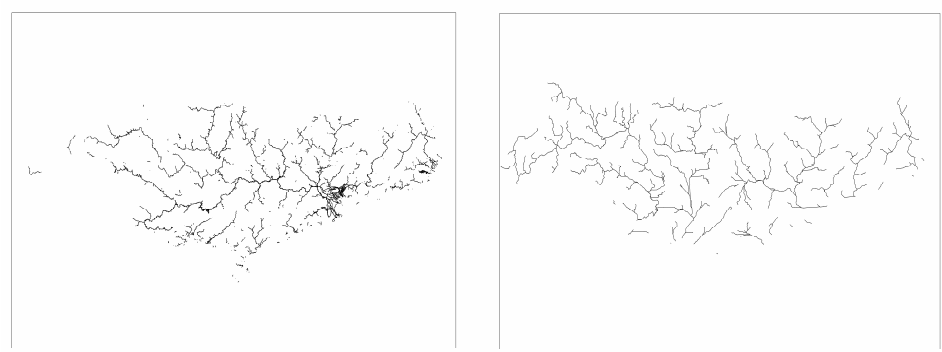
Figure 7. In the PRB, river in land use and the river under optimal threshold. On the left are the rivers obtained from the land use data. On the right is the river network extracted with the threshold 115,740.